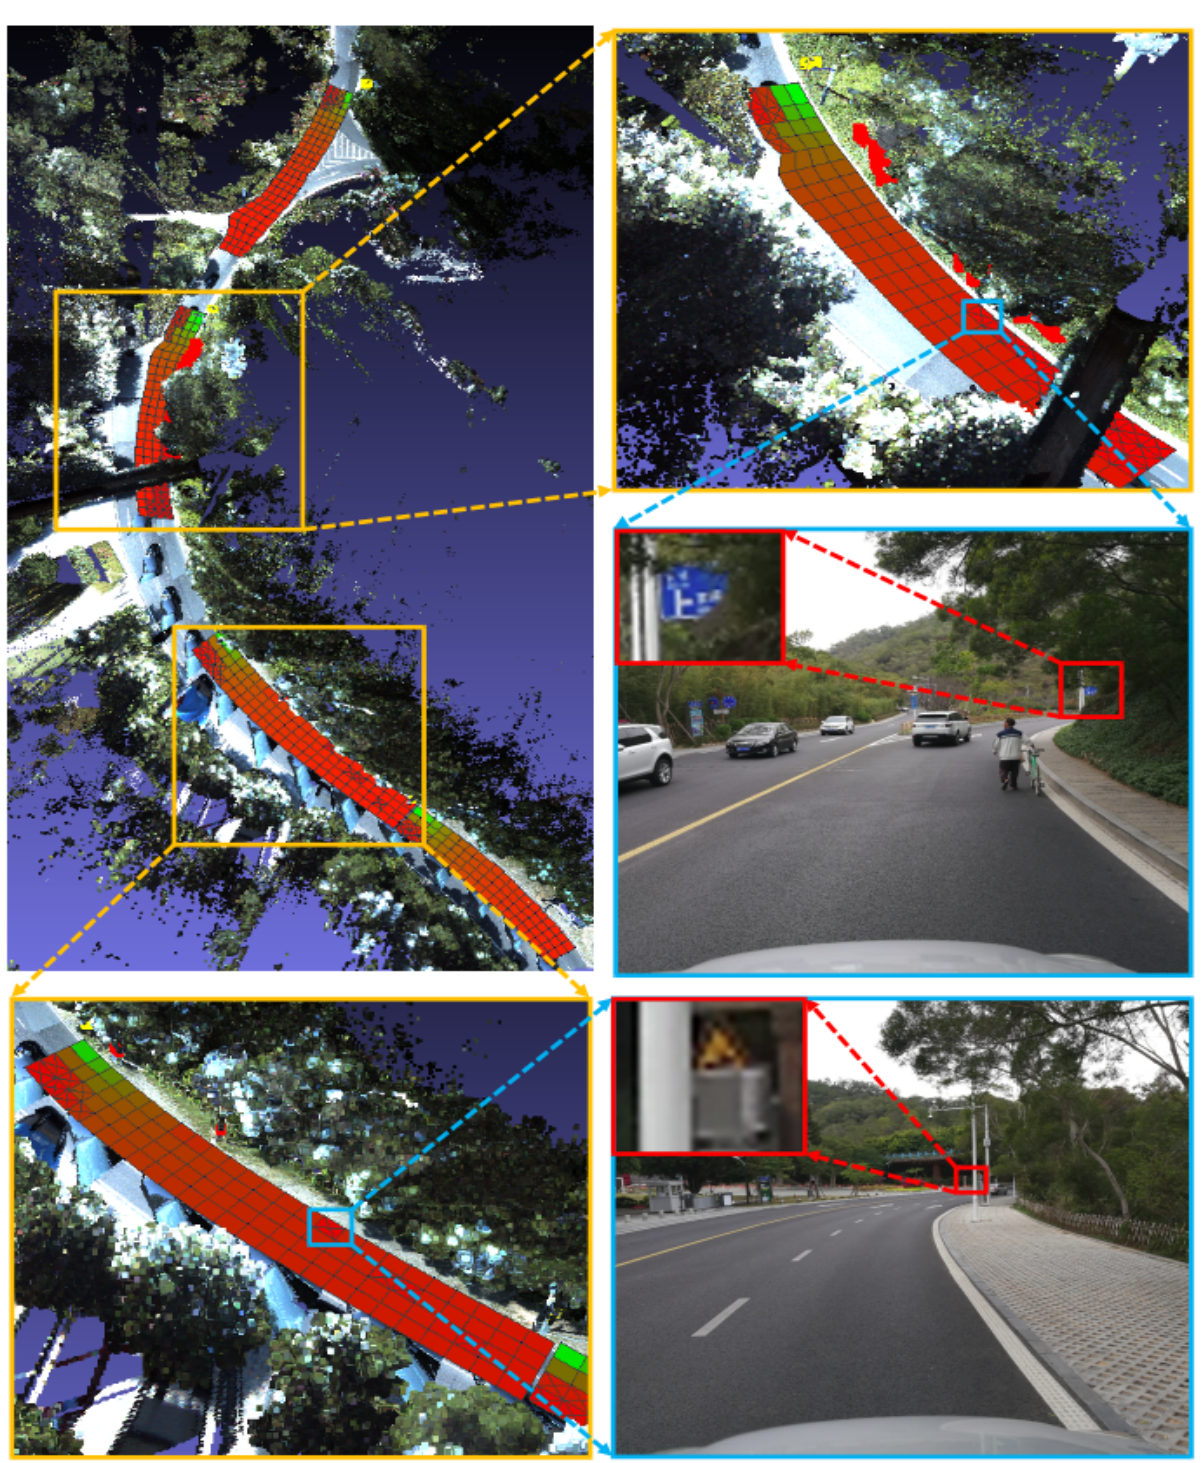
Figure 3. An application example of traffic signs’ occlusion detection and visibility fields calculation algorithm on large scale